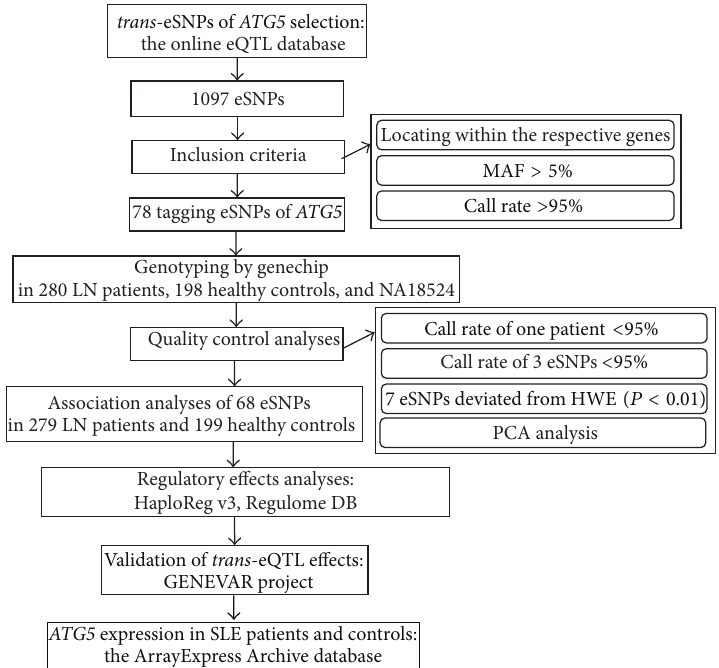
Figure 1: The workflow of genetic association study of ATG5 by trans -eQTL. (a) eQTL: expression quantitative trait loci, eSNP: expression single nucleotide polymorphism, HWE: Hardy-Weinberg equilibrium, LN: lupus nephritis, MAF: minor allele frequency, PCA: principle component analysis, and SLE: systemic lupus erythematosus. (b) The online eQTL database: mRNA by SNP Browser v 1.0.1, http://www.sph.umich.edu/csg/liang/imputation/byGene.html. (c) HaploReg v3 database: http://www.broadinstitute.org/mammals/haplor- eg/haploreg v3.php. RegulomeDB database: http://regulome.stanford.edu/. (d) GENEVAR project: the Gene Expression Variation project, http://www.sanger.ac.uk/humgen/genevar/. (e) The ArrayExpress Archive database: